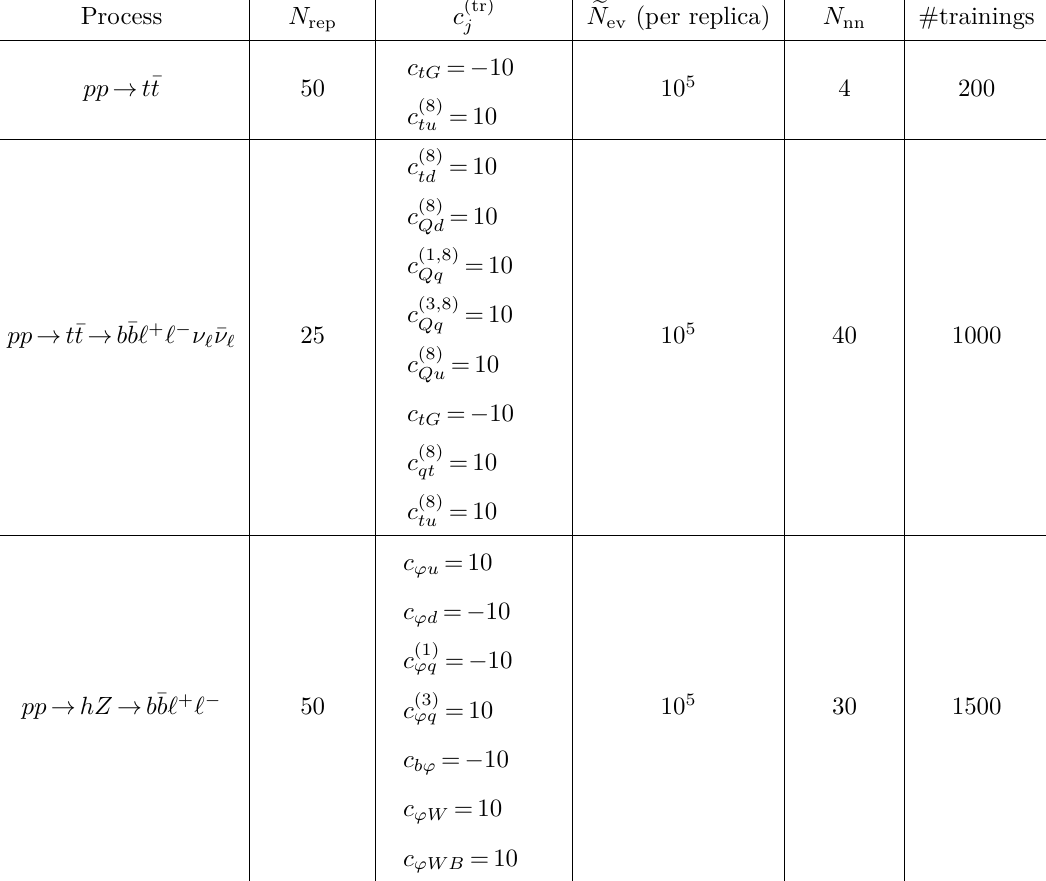
Table 6. Overview of the settings for the neural network training of the likelihood ratio eq. (3.19). For each process, we indicate the number of replicas N rep , the values of the EFT coefficients